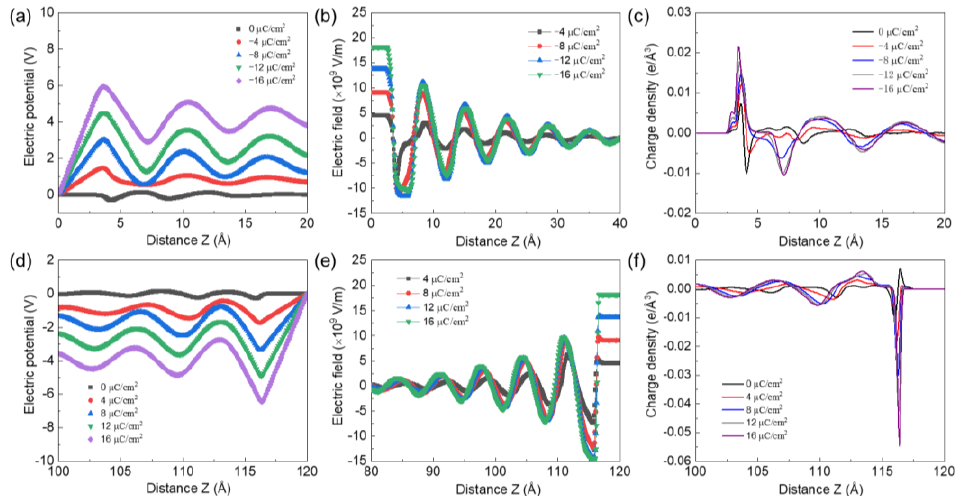
Figure 6. ( a ) Electric potential, ( b ) electric field, and ( c ) electrolyte charge density profile nearby negatively charged MoS 2 electrode. ( d ) Electric potential, ( e ) electric field, and ( f ) electrolyte charge density profile nearby positively charged MoS 2 electrode.